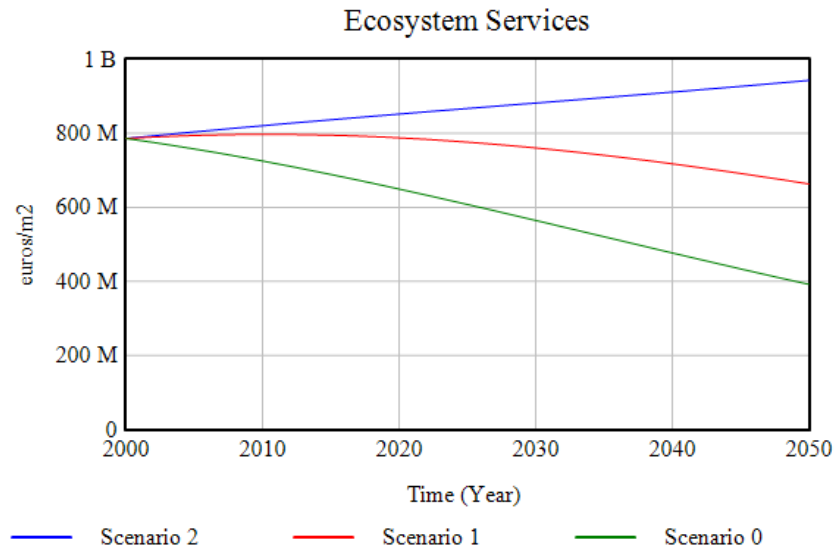
Figure 12. Population evolution for the three scenarios simulated over the period 2000–2500.